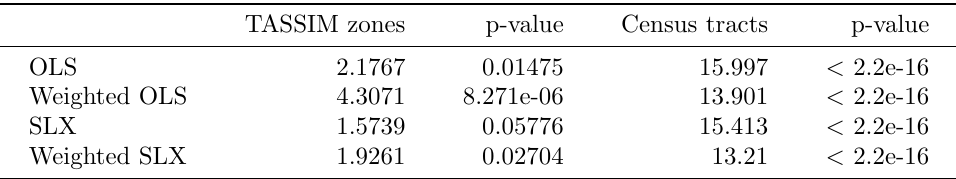
Table A.7: Standard deviates of Moran’s I test for spatial autocorrelation in least squares regression residuals for weighted and unweighted models and the 489 census tract data set and the 96 TASSIM zone data set.